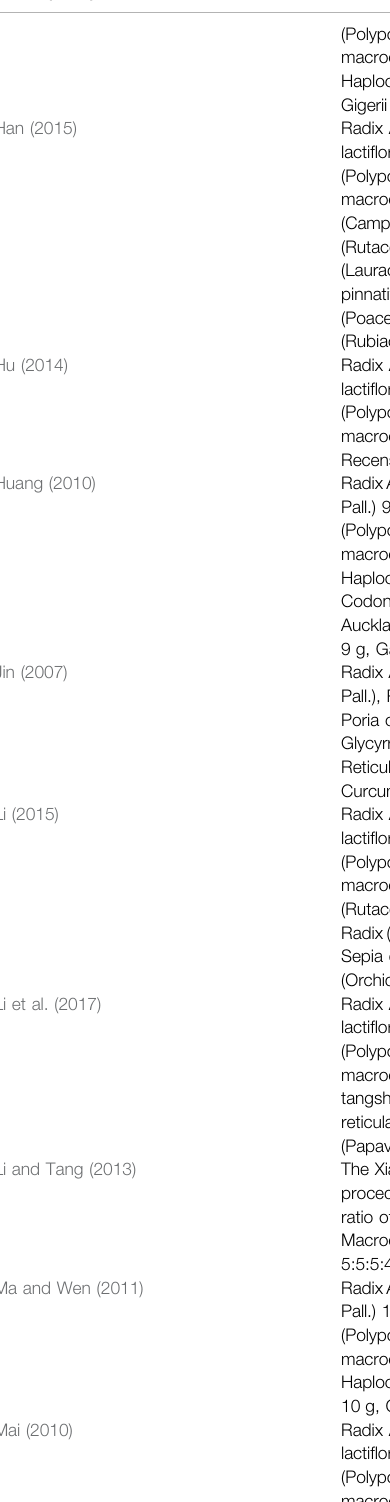
5:5:5:4:5:1. Eight of the pill was obtained from 3.0 g of the raw botanical drugs Ma and Wen